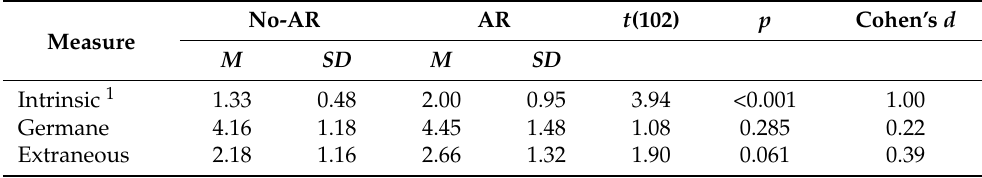
Table 4. Results of the t -tests for the different types of cognitive load in the first experiment (MP01). No-AR Measure